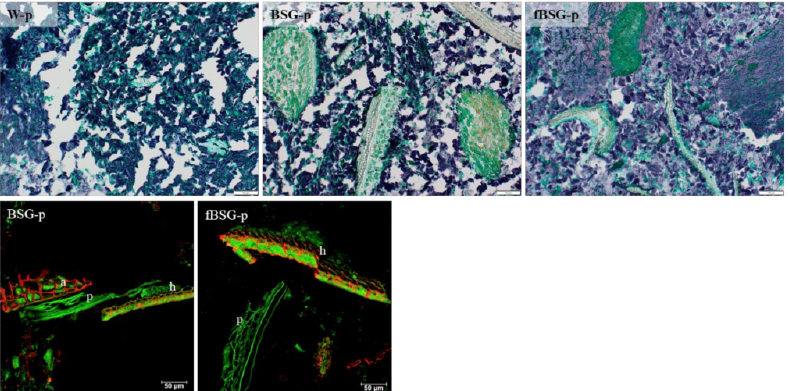
Figure 4. Brightfield and CLSM microscopy analysis performed on the in vitro-digested pasta containing fermented and native brewers’ spent grain: BSG-p, pasta containing native brewers’ spent grain; fBSG-p, pasta containing fermented brewers’ spent grain. W-p, pasta made with durum wheat semolina. Upper row: Bright field micrographs. Proteins are stained green and starch is stained blue. Scale bar 100 µ m. Lower row: CLSM micrographs. Arabinoxylan is shown in red and autofluorescence (cell walls, protein) in green. h = hull (palea and lemma), a = aleurone, p = pericarp. Scale bars 50 µ m.